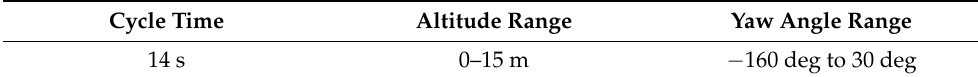
Figure 9. The planned open-loop trajectory. Table 2. Trajectory conditions.